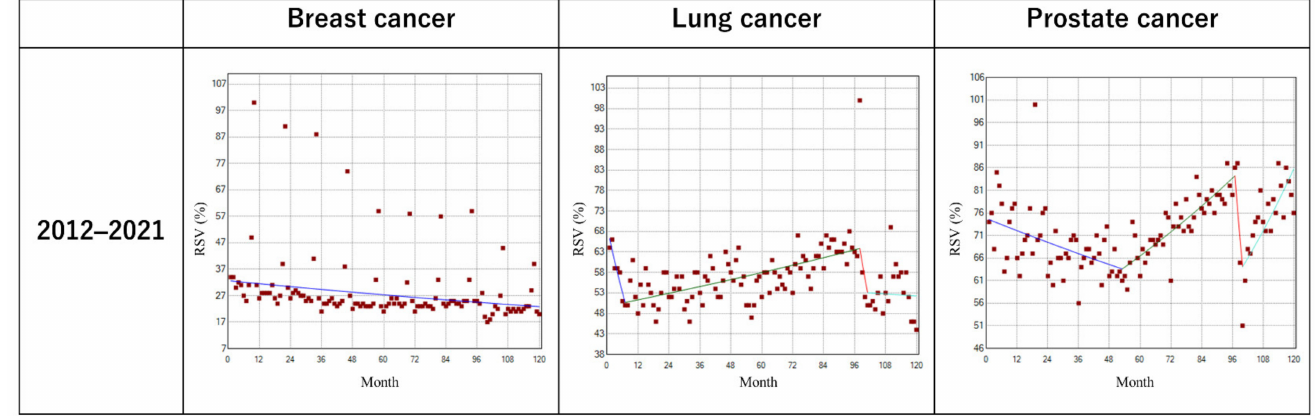
Figure 3. The trends in monthly relative search volumes between 2012 and 2021 with relevant search terms. Monthly RSVs for the search terms “Breast cancer”, “Lung cancer”, and “Prostate cancer” between 2012 and 2021 are